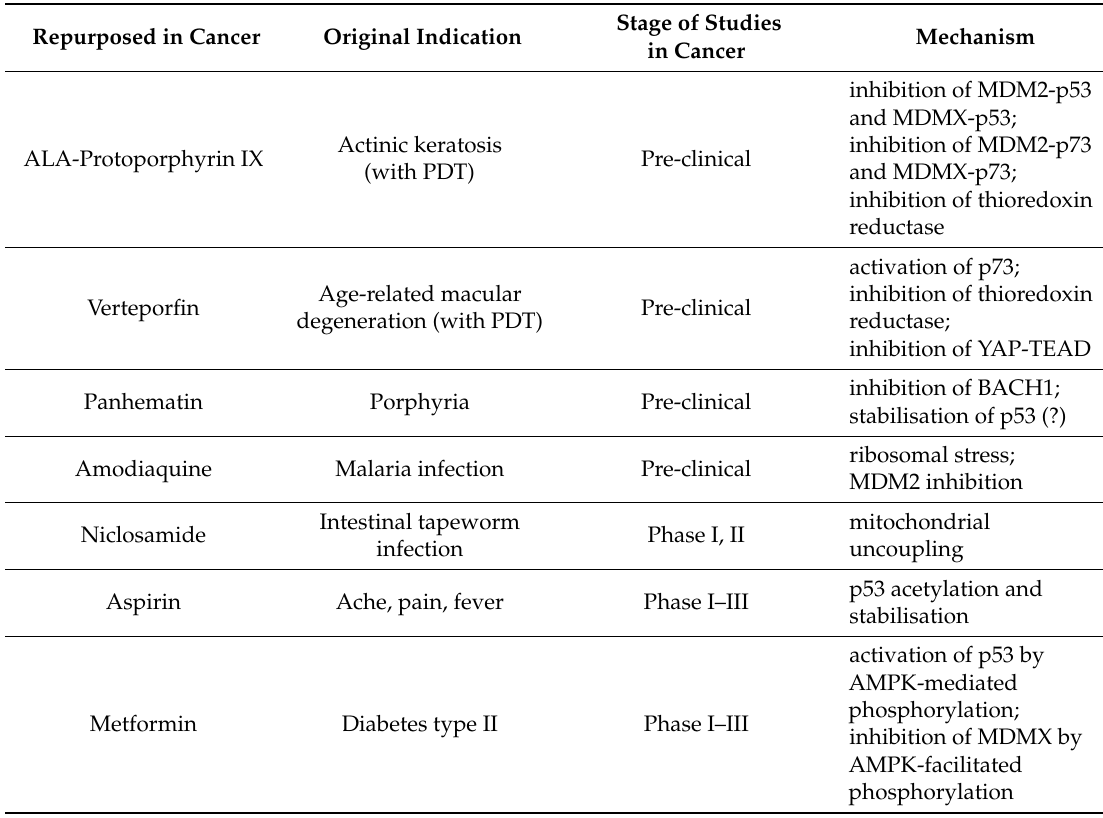
Table 1. Promising candidates for drug repurposing in oncology targeting p53 proteins. Selected drugs were described to show a significant degree of p53-dependent action in cancer cells. All of the relevant literature is referred to in the main text. A question mark indicates a not fully depicted